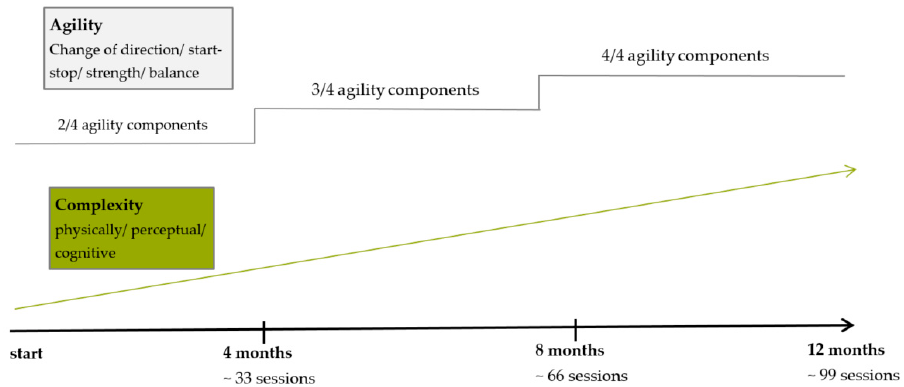
Figure 2. Training design and progression.